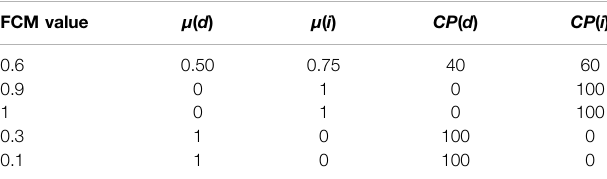
TABLE 4 | Summary of the transition from the FCM to the CPT for the variable “ protected areas.